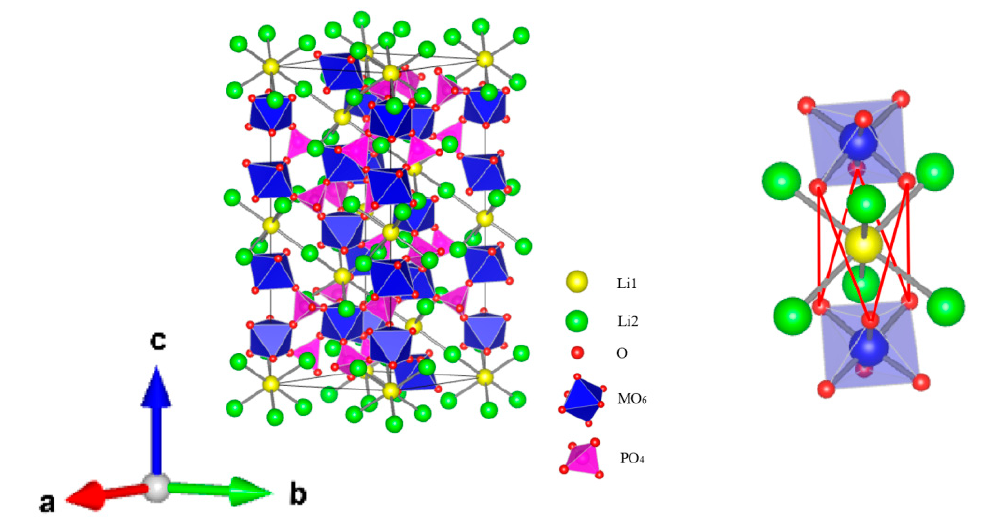
Figure 5. Crystal structure of NASICON-type LiM 2 (PO 4 ) 3 . Li + motion pathways are drawn between Li1 and Li2 sites. The structure on the right is a close-up view of the conduction bottleneck region and the constrictive windows between O atoms are traced in red.